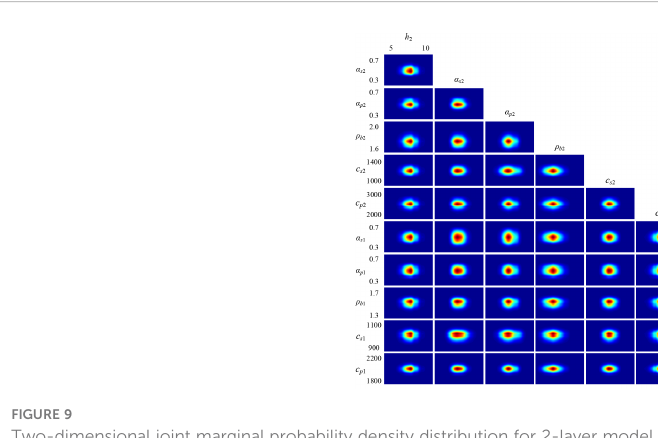
the comparison of the transmission loss curves TL p (in Figure 14A) and the waveguide characteristic impedance curve ZL Zz (in Figure 14B) obtained by the inversion of the two-layer model with the experimental data. The result of the inversion is the dashed line, and the experimental data is the solid line. Comparing the distribution trends of TL p and ZL Zz , it can be seen that ZL Zz has a higher degree of consistency, especially at a larger distance. The ZL Zz comparison results were better and showed higher stability. The RMS values of TL p and ZL Zz are 3.7 dB and 2.3 dB, respectively. A better fi t for ZL Zz was also indicated by the RMS values.